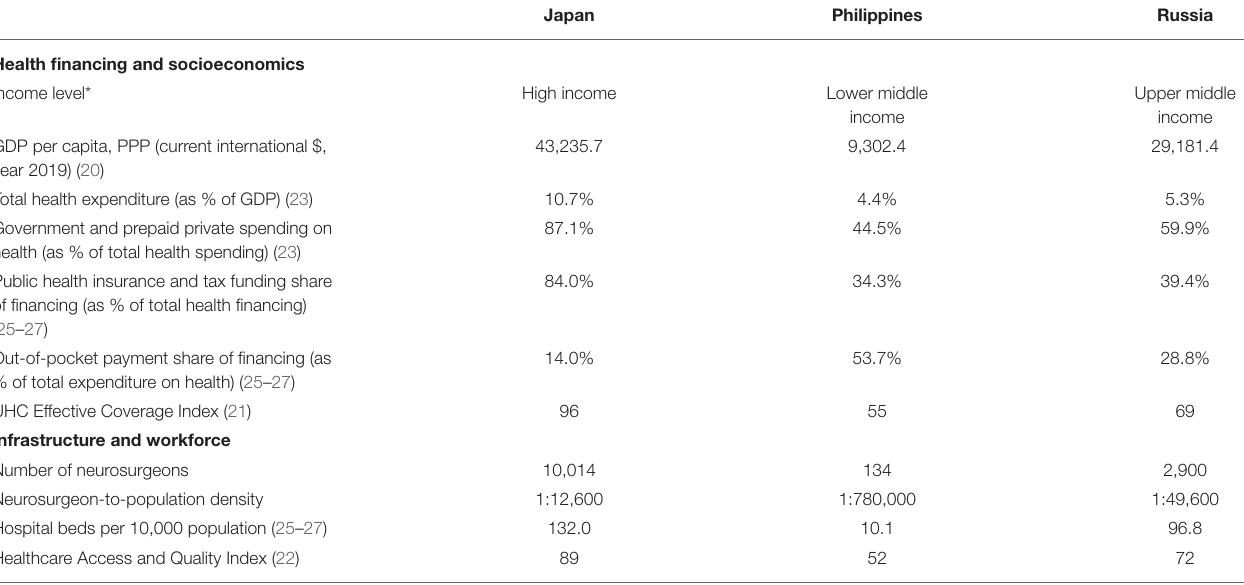
TABLE 5 | Country-level data of the three countries in terms of relevant metrics of Global Surgery indicators and social determinants of health.